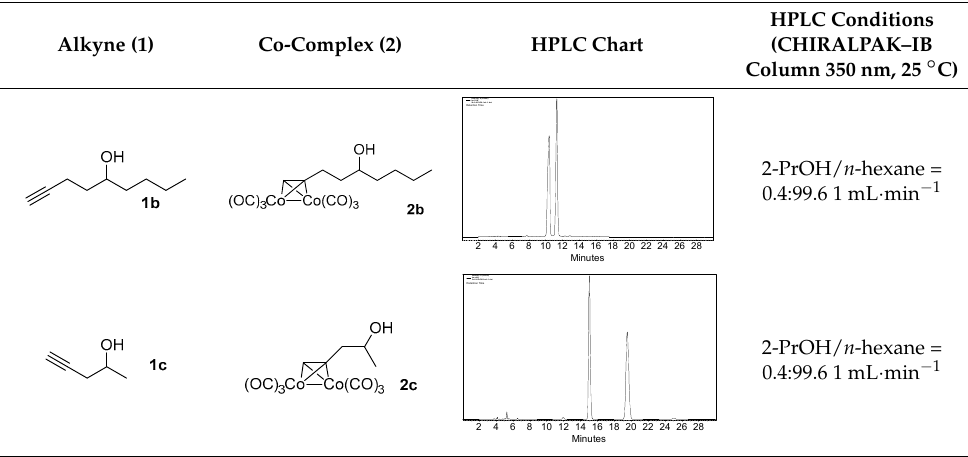
Table 1. Scope of alkynes for HPLC resolution of their Co-complexes.